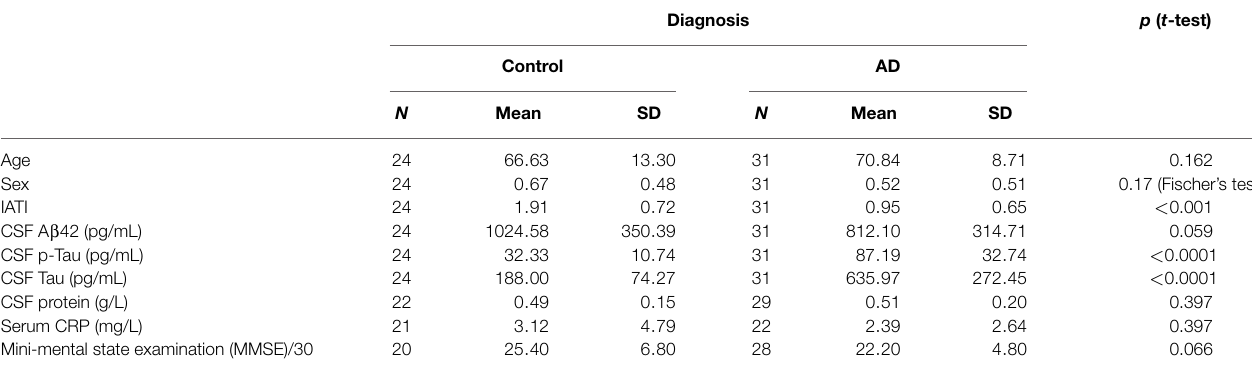
TABLE 1 | Demographic and CSF biomarkers in the population .